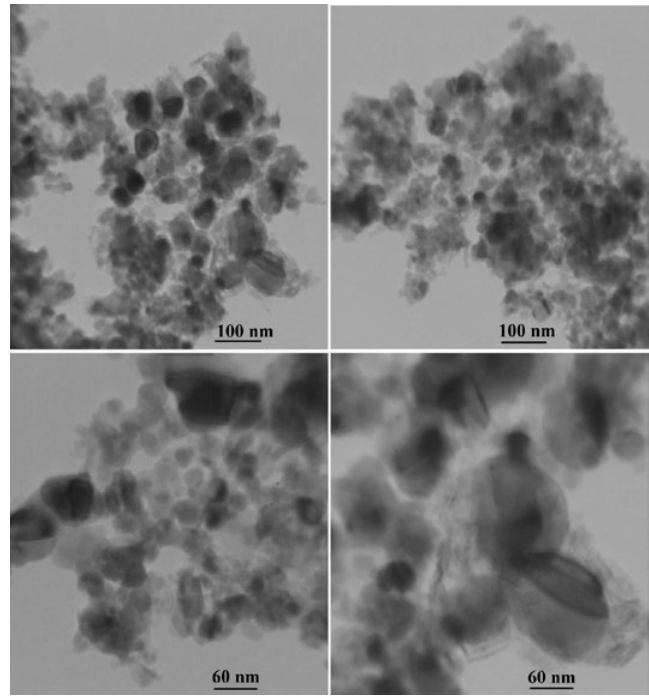
Fig. 2. TEM images of FNMMO calcined at 500